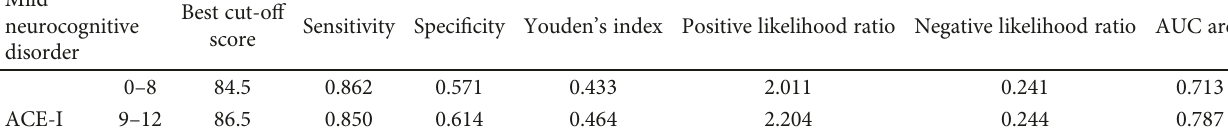
Table 2: Diagnostic accuracy of ACE-I, ACE-III, Mini-ACE, and MMSE for detecting mild neurocognitive disorder in the respect of education years.